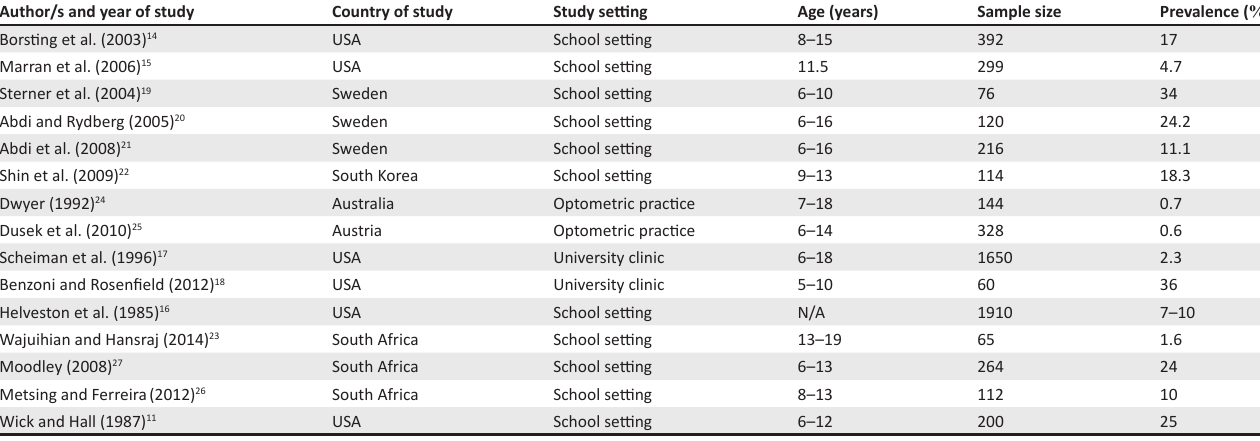
TABLE 2: Summary of studies on accommodative insufficiency with prevalences. Author/s and year of